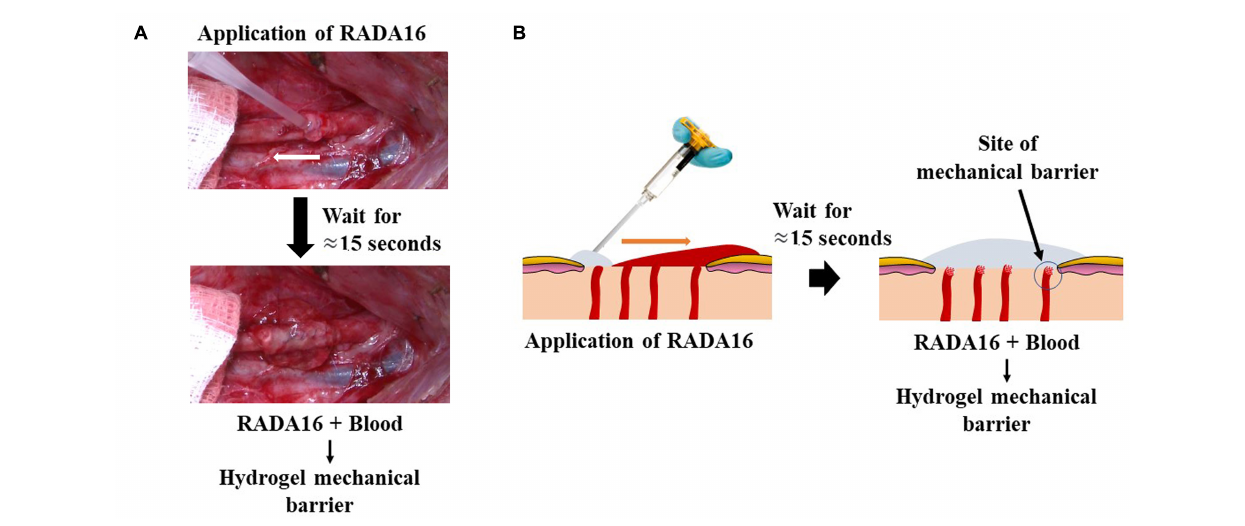
FIGURE 5 | Hemostatic mechanism of action of RADA16 self-assembling peptide hydrogel on bleeding wound surfaces. Upon contact with physiological fluids present at the surgical site, the RADA16 solution rapidly forms a transparent hemostatic in situ hydrogel barrier on the oozing suture lines of vascular anastomoses (A) and the topical/surgical oozing sites such as ulcer and resected tissue after surgery (B) . In a porcine model using the femoral artery, a longitudinal suture line was conventionally irrigated and sponge-dried, and RADA16 was syringe-applied to the suture line on the vessel’s outer surface. The white arrow shows the direction of syringe movement during application. RADA16 solution can stop residual bleeding at blood vessel suture lines and anastomoses sites during cardiothoracic and vascular surgeries (A) . In a general topical/surgical bleeding site, in situ hemostatic hydrogel formation is initiated at the interface between the bleeding site and the applied RADA16 layer. This is represented diagrammatically (B) . The transparent nature of the hydrogel allows easy visualization of the surgical field and underlying sutures and bleeding sites, thus enabling the surgeon to evaluate the surgical site for satisfactory hemostasis and the possible need to perform